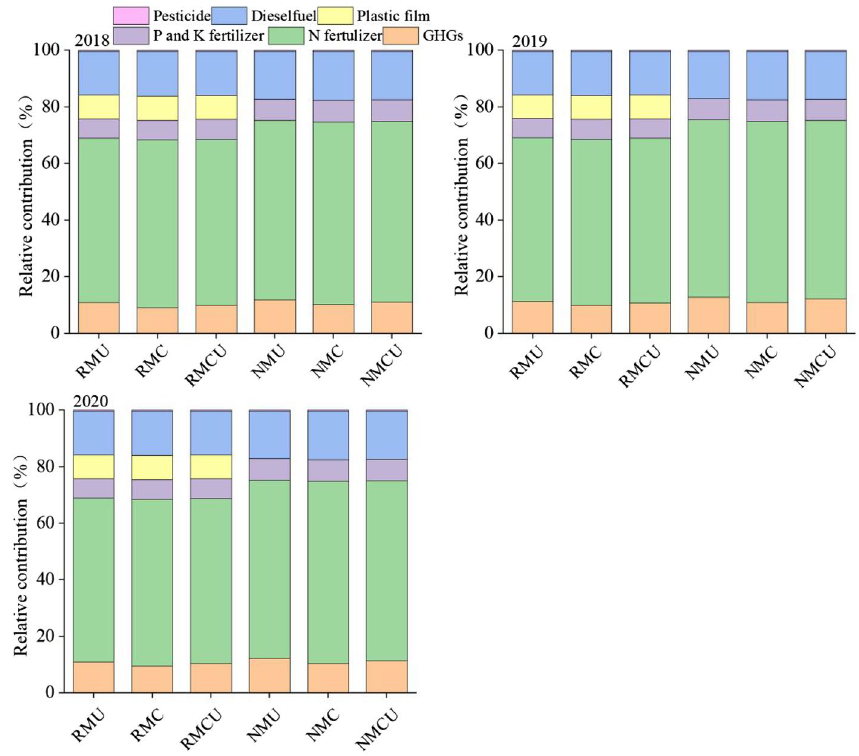
Figure 3. The relative contributions of different inputs to the total GHG emissions under different treatments in 2018–2020 growing seasons. RM plastic film mulching, NM no plastic film mulching, U conventional urea, C controlled-release urea, CU a mixture of equal amount of conventional urea and controlled-release urea at 1:1